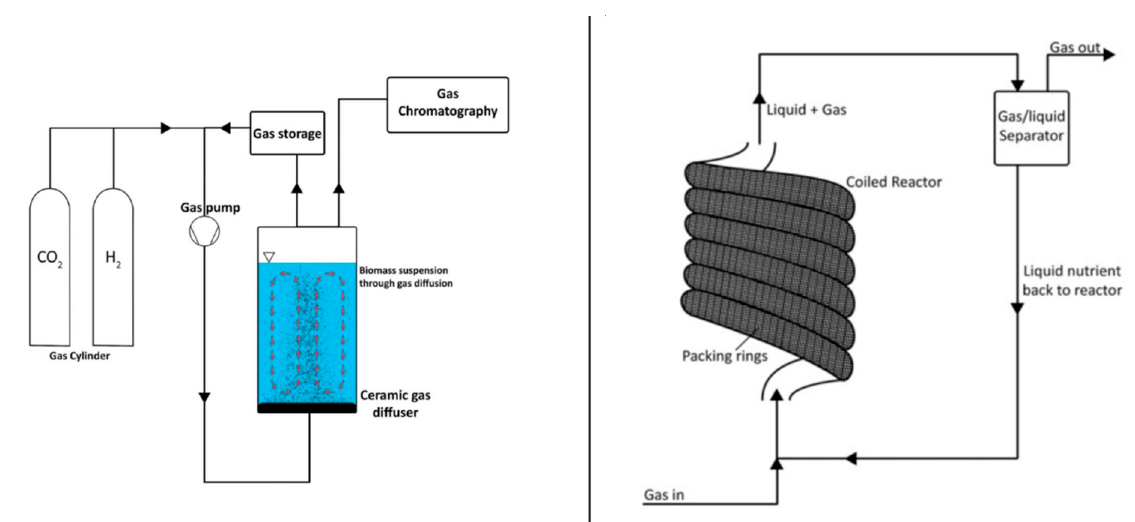
Figure 5. ( Left ) Diffusion based reactor. ( Right ) Tubular loop reactor made of a. narrow diameter pipe and packed, fixed biofilm. Reprinted from [71] (Copyright 2019), with permission from Taylor and Francis Group.